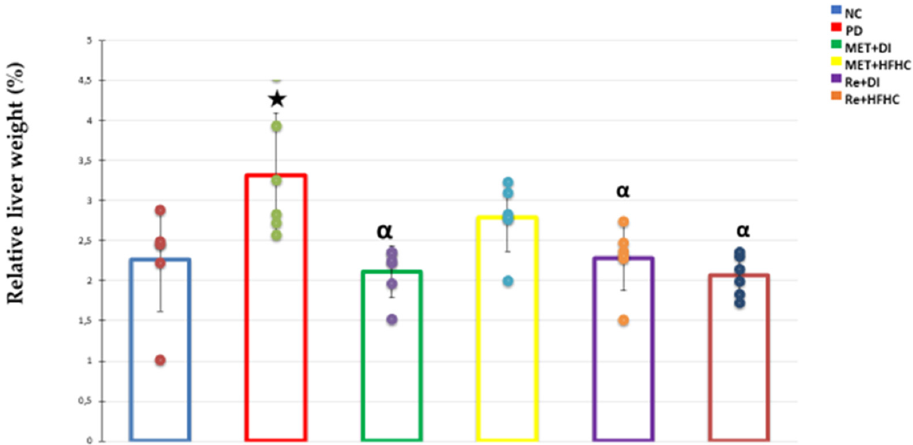
Figure 5. Relative liver weight in normal control (NC), prediabetic control (PD), metformin and diet intervention (MET + DI), metformin and high fat–high carbohydrate (MET + HFHC), rhenium (V) compound and diet intervention (Re + DI) and rhenium (V) compound and high fat–high carbohydrate (Re + HFHC) groups after 12 weeks of treatment. Values are presented as means ± SD and individual data points ( n = 6). * p < 0.05 by comparison with NC, α p < 0.05 by comparison with PD, MET + DI, MET + HFHC, Re + DI and Re + HFHC.